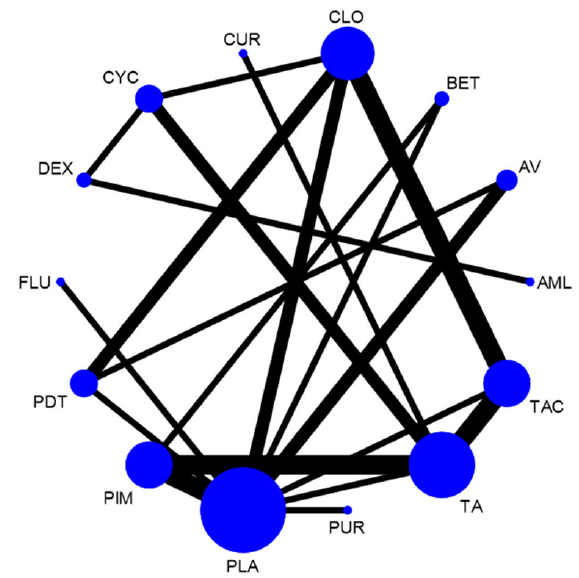
Figure 16. Network plot: Adverse Effects (subgroup analysis). Abbreviations: AML, amlexanox paste; AV, aloe vera; CUR, curcumin gel; PDT, photodynamic therapy; PLA, placebo; PUR, purslane; TAC, tacrolimus; FLU, flucinonide acetonide; CLO, clobetasol propionate; PIM, pimecrolimus; BET, betamethasone; TA, triamcinolone acetonide; DEX, dexamethasone; CYC, cyclosporine.